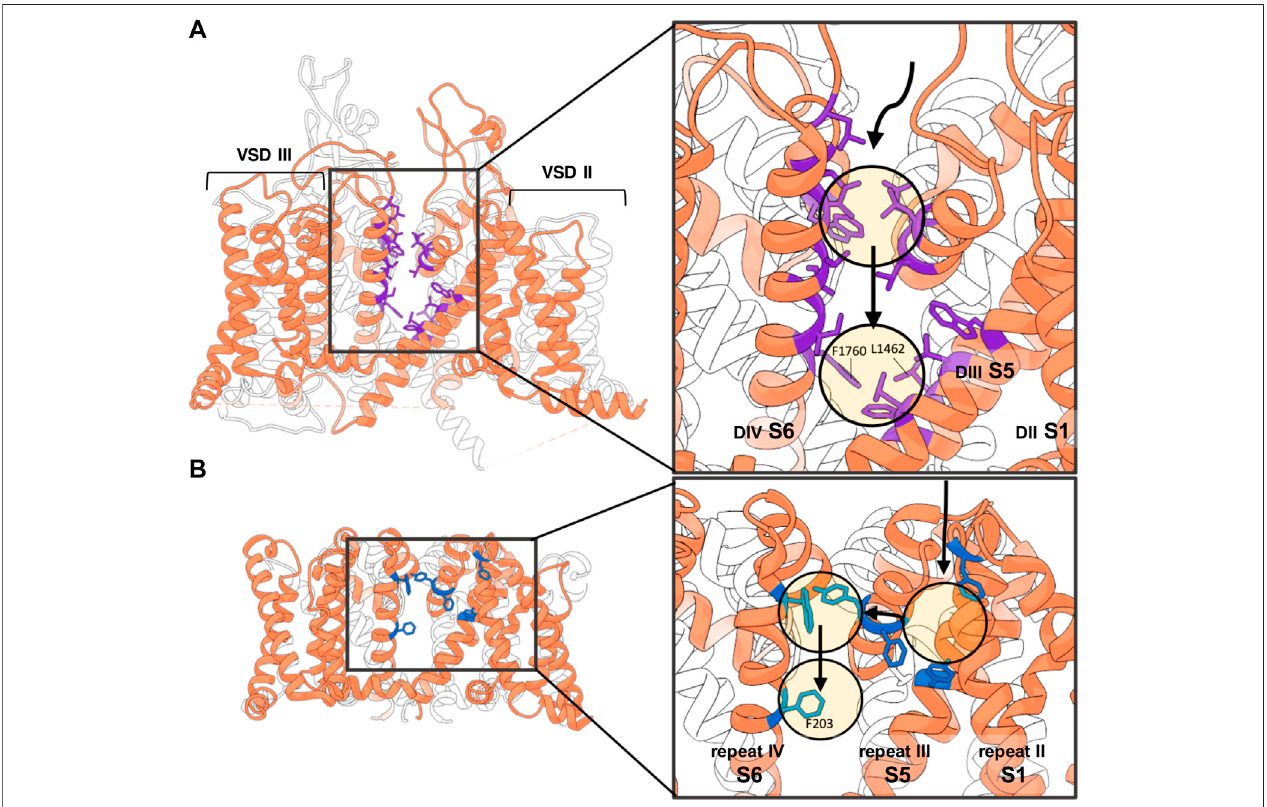
FIGURE 4 | Non-membranous lipophilic LA access via side fenestrations. (A) In the hydrophobic access pathway to the pore of the hNav1.5 homology model according to the simulations of (Nguyen et al., 2019) the LA molecule is stabilized along its trajectory by the following residues, colored in purple: L1338, L1342, and W1345 (in DIIIS5); L1410, L1413, and Q1414 (in P1 helix of DIII); L1462 and F1465 (in DIIIS6); W1713, L1717, and L1721 (in P2 helix of DIV); and I1749, T1753, I1756, and I1757 (in DIVS6); and at the entrance of the fenestration F1760 (in DIVS6) and L1462 (in DIIIS6) (Nguyen et al., 2019). Numberings are based on hNav1.5 sequence. (B) Lipohilic pathway of benzocaine accessing the pore domain of NavAb via the side fenestration. Along its trajectory it encounters low-energy hydrophobic pockets formed by the following residues colored in blue: F37, F142, F167, Y168, W195 and F203 (Boiteux et al., 2014). Numberings are based on NavAb